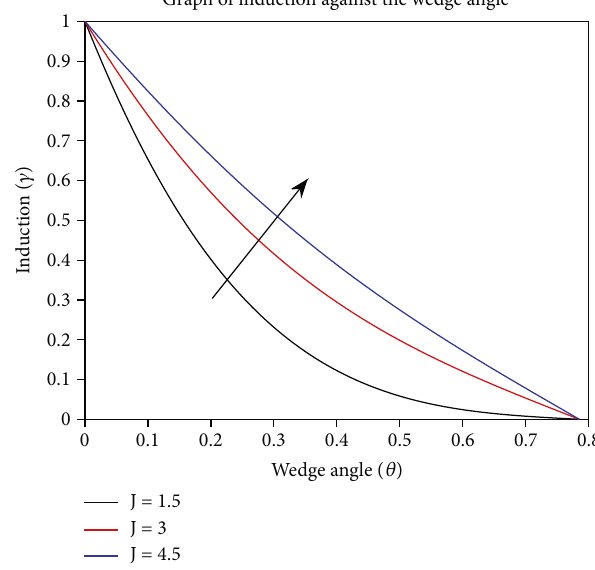
Figure 11: E ff ect of varying the Joule heating parameter on velocity.